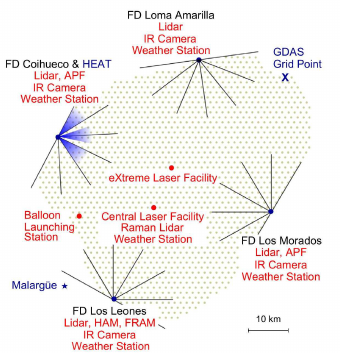
Figure 1. Map of the Pierre Auger Observatory atmospheric monitoring